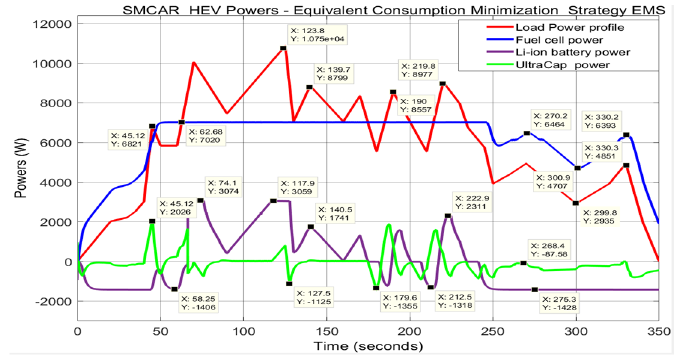
Figure A8. SMCAR HEV Powers—Equivalent Consumption Minimization EMS.